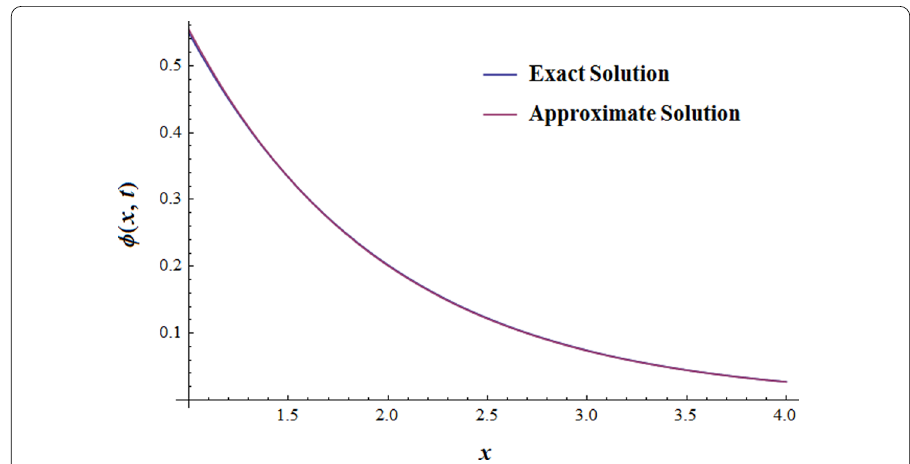
Figure 3 Comparison of the exact solution and the approximate solution given in Eq. (44)